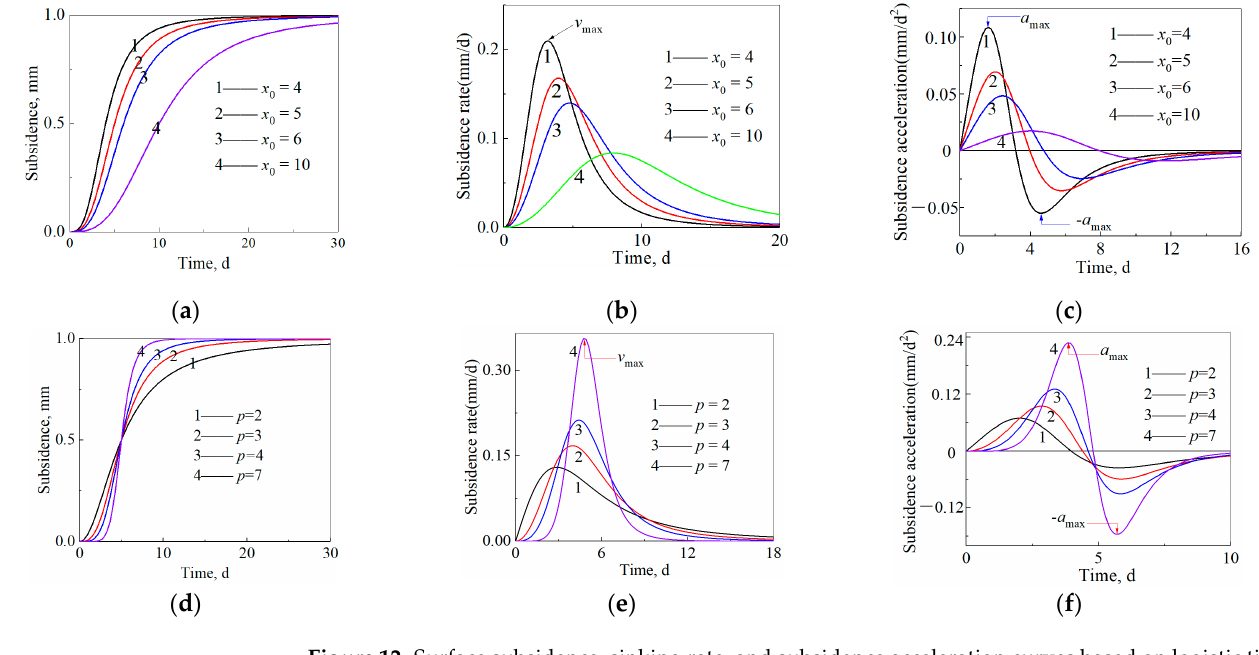
Figure 12. Surface subsidence, sinking rate, and subsidence acceleration curves based on logistic time function: ( a ) subsidence curves ( p = 3); ( b ) subsidence rate curves ( p = 3); ( c ) subsidence acceleration curves ( p = 3); ( d ) subsidence curves ( x 0 = 5); ( e ) subsidence rate curves ( x 0 = 5); ( f ) subsidence acceleration curves ( x 0 = 5).